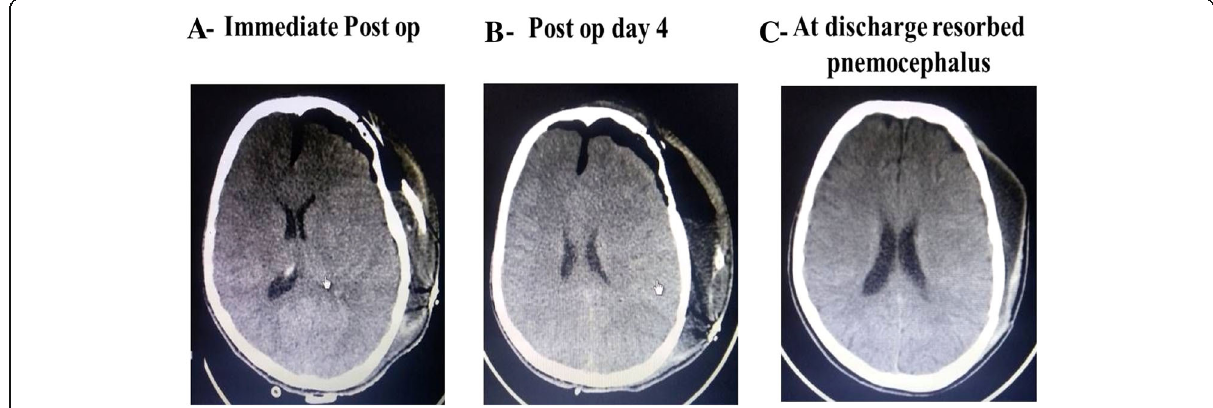
Fig. 2 CT scan showing the progression of pneumocephalus immediate post-op day1. The immedeate post-op images showes mass effect compressing the ventricles, which appered to be resolving edema with reduced mass effect in the image taken on Day